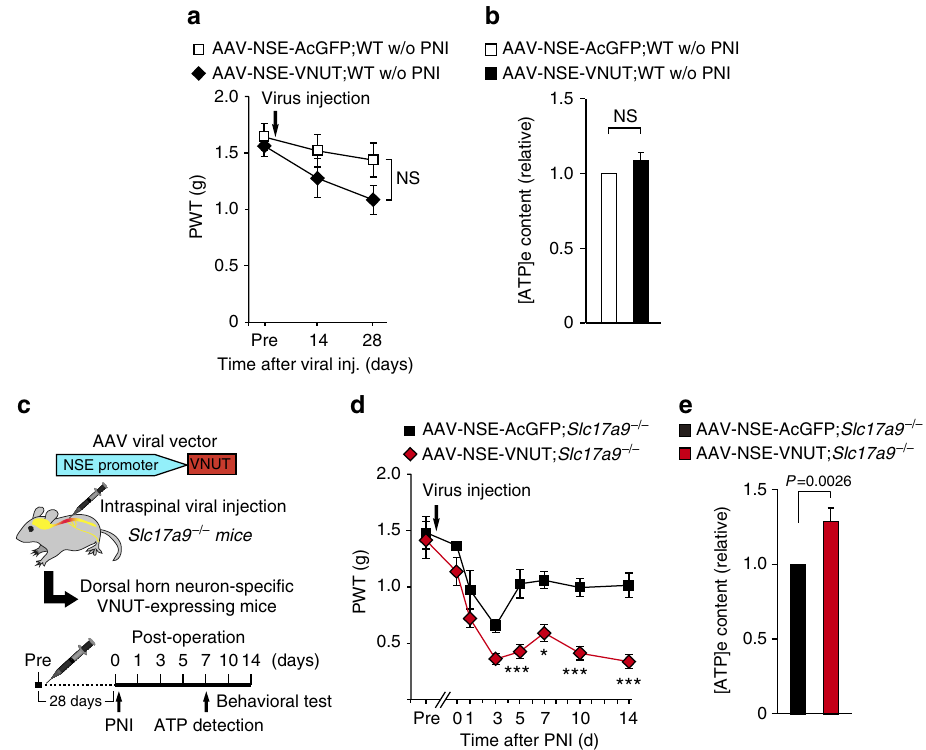
Figure 7 | Ectopic expression of VNUT in SDH neurons of Slc17a9 (cid:2) / (cid:2) mice rescues tactile allodynia and enhances spinal ATP after PNI. ( a ) PWTof WTmice before (pre) and after intraspinal injection of AAV-NSE-AcGFP or AAV-NSE-VNUTviral vectors without (w/o) PNI ( n ¼ 6 , two-way ANOVA with post hoc Bonferroni test). ( b ) Measurement of [ATP] e content in the ACSF media of spinal cord slices isolated from WT mice 28 days after intraspinal injection with AAV-NSE-AcGFP or AAV-NSE-VNUTviral vectors without PNI ( n ¼ 13 , Wilcoxon matched-pairs signed rank test). ( c ) Schematic diagram of experimental protocol for d , e . ( d ) PWTof Slc17a9 (cid:2) / (cid:2) mice intraspinally injected with AAV-NSE-AcGFP or AAV-NSE-VNUTviral vectors before and after PNI (AAV-NSE-AcGFP; Slc17a9 (cid:2) / (cid:2) : n ¼ 5 , AAV-NSE-VNUT; Slc17a9 (cid:2) / (cid:2) : n ¼ 6 ; * P o 0.05, *** P o 0.001 versus AAV-NSE-AcGFP; Slc17a9 (cid:2) / (cid:2) , two-way ANOVA with post hoc Bonferroni test). ( e ) Measurement of [ATP] e content in the ACSF media of spinal cord slices isolated from Slc17a9 (cid:2) / (cid:2) mice intraspinally injected with AAV-NSE-AcGFP or AAV-NSE-VNUTviral vectors 7 days after PNI ( n ¼ 14, Wilcoxon matched-pairs signed rank test). Values are means ± s.e.m. NS, not